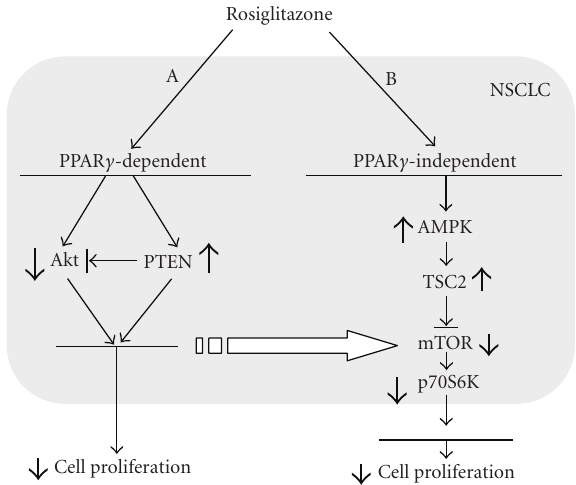
Figure 2: Rosilitazone stimulates NSCLC proliferation by a ff ecting the Akt/mTOR pathway through PPAR γ -dependent and PPAR γ - independent